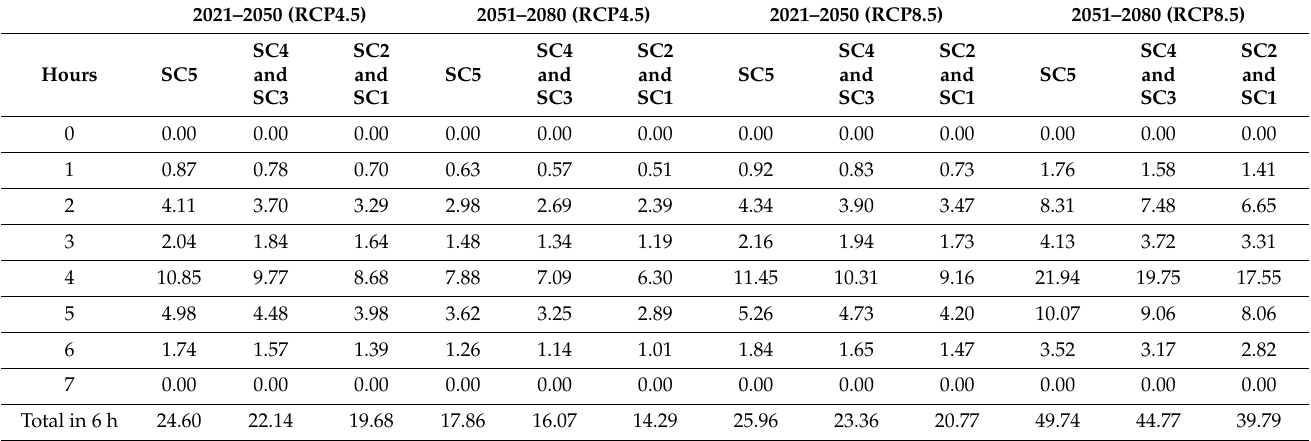
Figure 36. Structure of the RS Minerve Model for the simulations of events with different climate change scenarios. Table 11. Precipitation intensity over each sub-basin (mm/h) for RCP4.5 and 8.5 scenarios, from 2021 to 2050 and from 2051 to